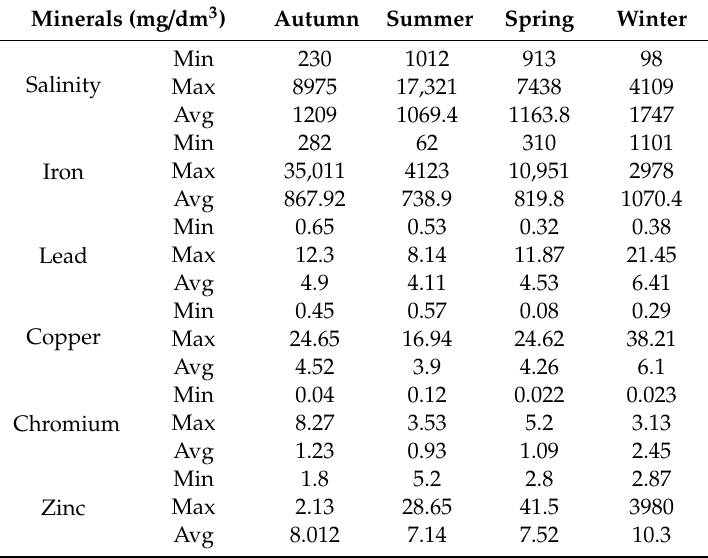
Figure 5. Laboratory measurements for the four seasons of 2017, Pb, Cu, Cr, and Zn. Table 2. Laboratory measurements of salinity and chemicals over four seasons in